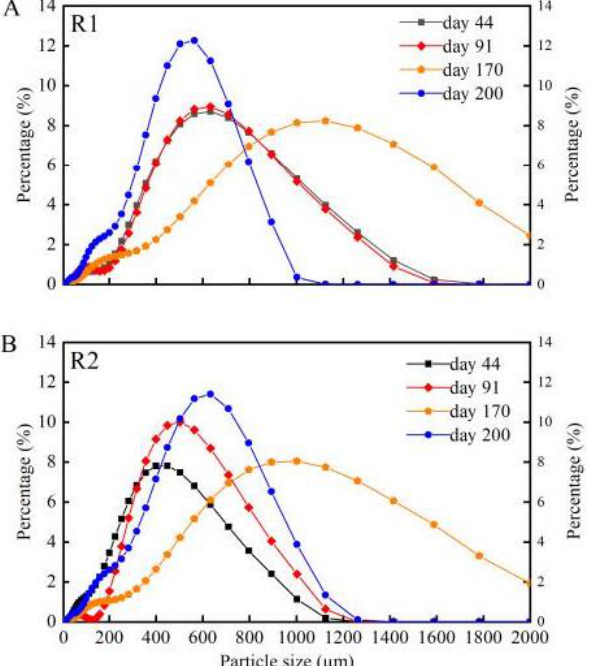
Figure 3. The change in mean sizes of the aerobic granules in R1 and R2 during the long-term operation period. ( A ) for R1; ( B ) for